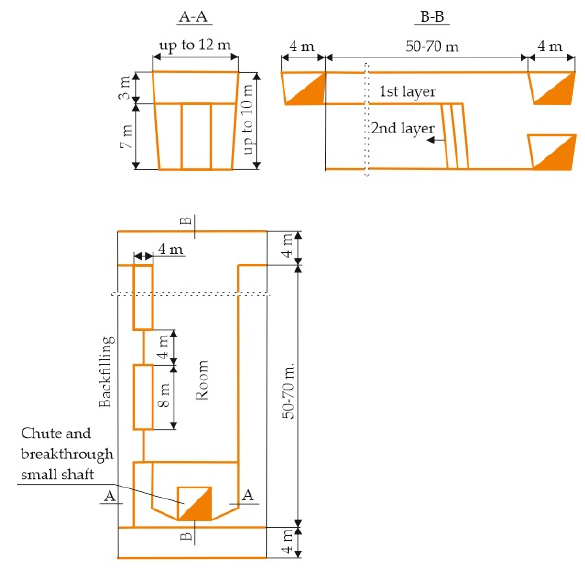
Figure 11. Room and pillar mining method in an orebody with a thickness of up to 10 m.